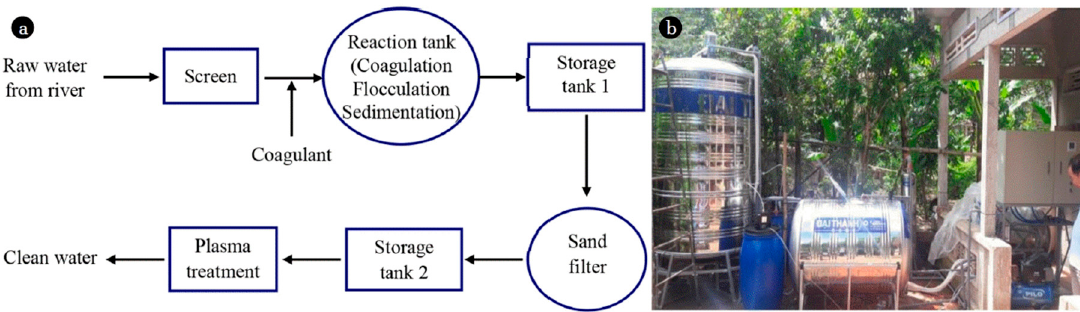
Figure 6. ( a ) Block diagram of water treatment and ( b ) water treatment with NTAPP (reprinted from [44]).